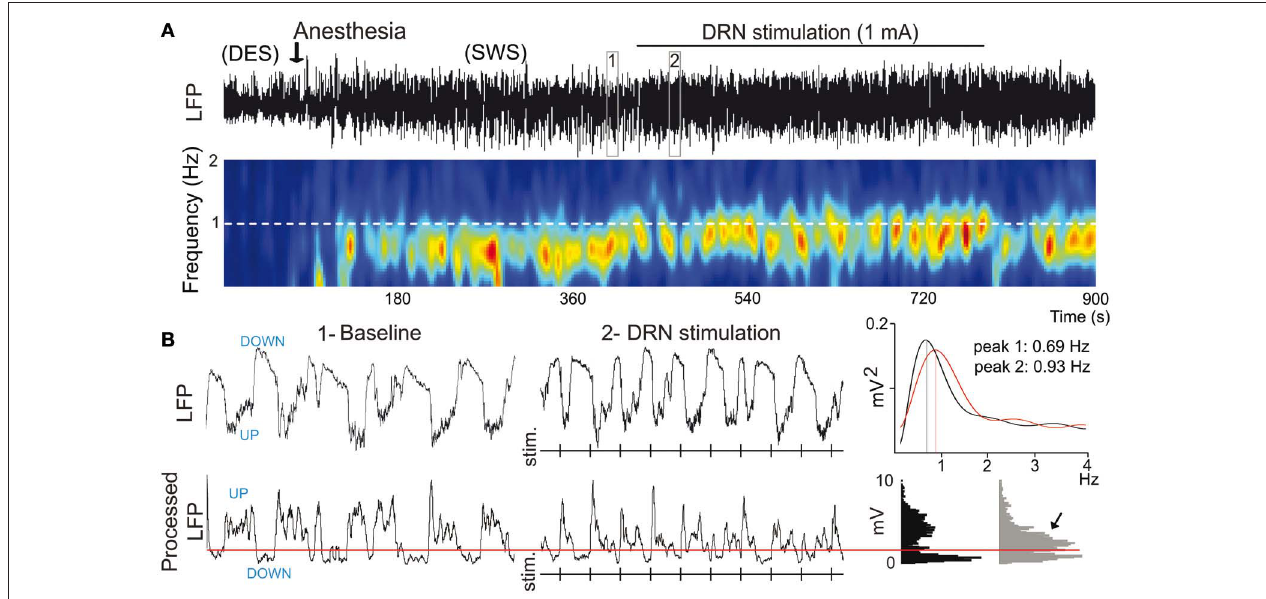
( ∼ 0.7Hz) increases in frequency toward the frequency of stimulation during DRN stimulation. (B) Top, expanded 10-s traces from (A) . Vertical lines correspond to times of DRN stimulation. Power spectra for 1min segments that contain the 10-s traces in boxes 1 and 2 are shown on the far right. Bottom, LFPs were processed off-line for an accurate measure of UP-state duration. A threshold was set (red line) to discriminate UP states. Note the increase in UP-state potentials during the stimulations (arrow). Modified from Puig et al.